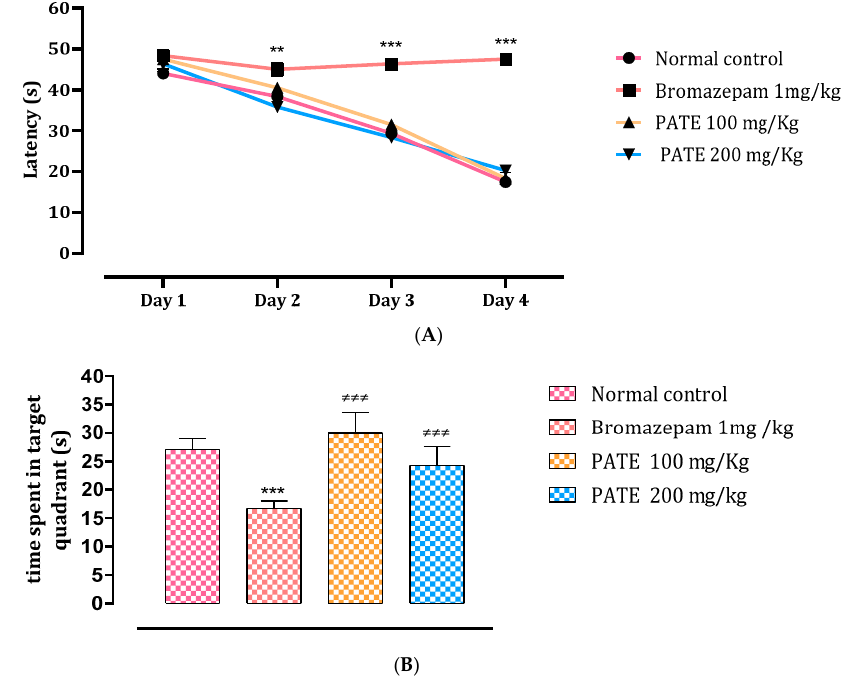
Figure 7. Effects of PATE in the MWMT. ( A ) Latency time and ( B ) time spent in the target quadrant. Data are represented as mean ± SEM. (** p ≤ 0.01, *** p ≤ 0.001 compared to the normal control group. ≠≠≠ p ≤ 0.001 compared to the positive